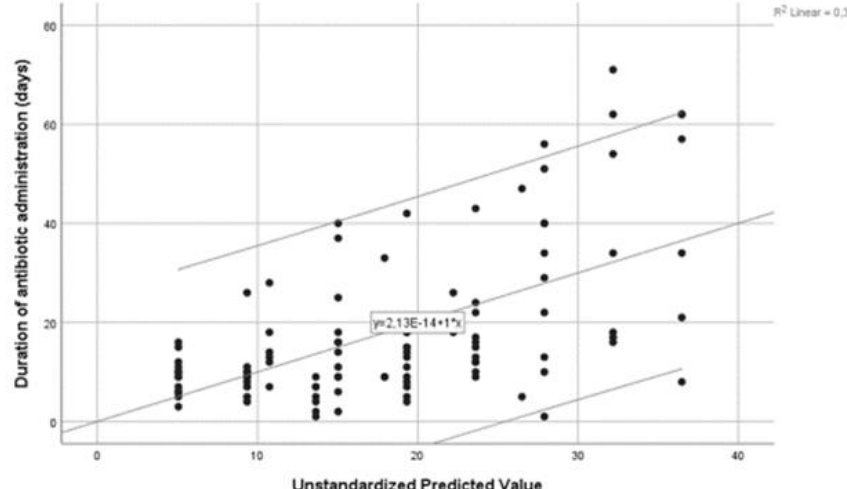
Figure 6. Scatter plot depicting the multivariate relationship between the duration of antibiotic administration and the independent variables bacteria number and radiological signs of pulmonary infiltration represented by the unstandardised predicted value. Line of best fit and confidence interval of 95%.